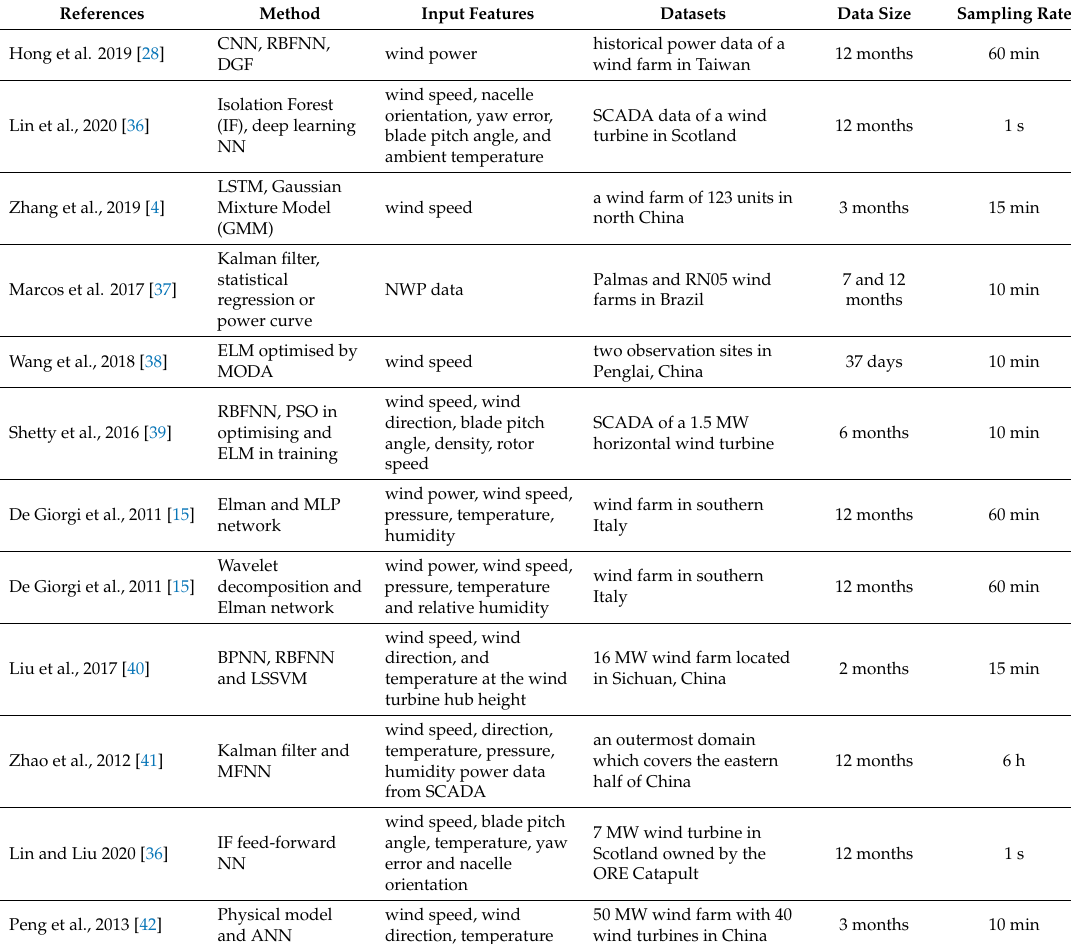
Table 4. Hybrid wind power